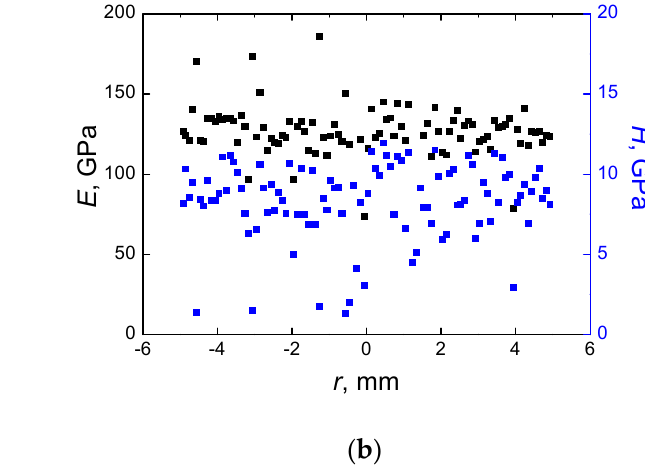
Figure 10. ( a ) P - h diagrams for the TiZrHfMoCrCo alloy taken from areas ( A2 ) and ( C15 + C14 ). ( b ) Dependences of nanohardness ( H ) and Young’s modulus ( E ) for the TiZrHfMoCrCo alloy taken from the sample diameter.